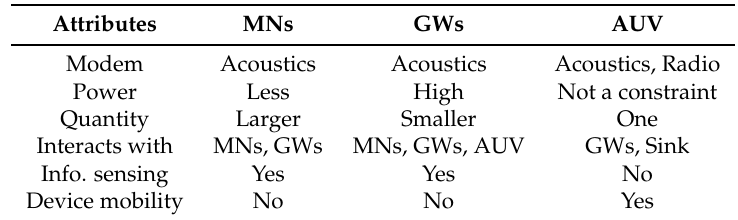
Figure 3. Network architecture. Table 2. Attributes of types of deployed